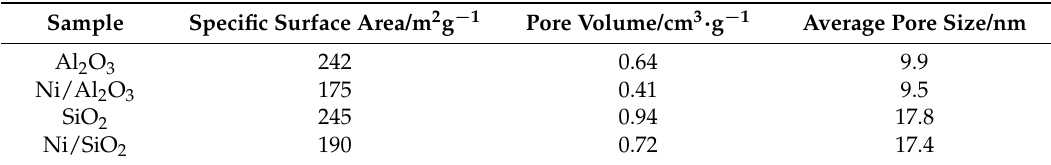
Table 1. Specific surface area and pore structure of the supports and the catalysts. Table 2. Evaluation reaction result of Ni/SiO 2 and Ni/Al 2 O 3